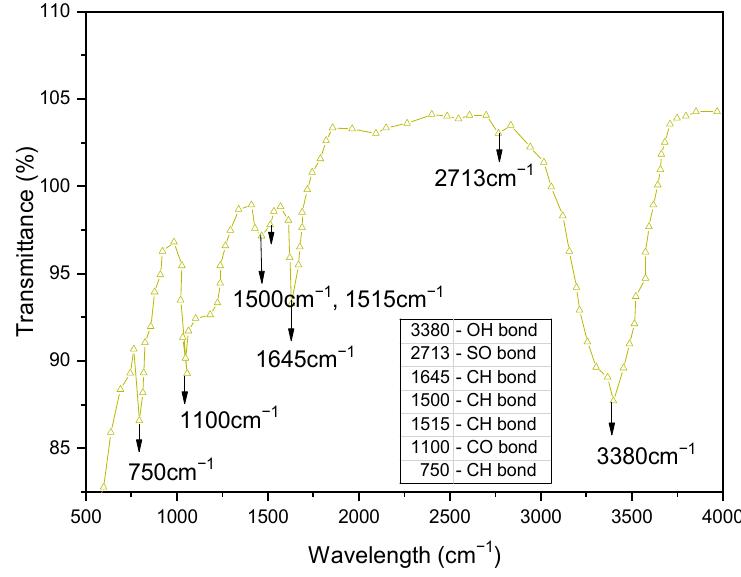
Figure 13. FTIR pattern of calcium lignosulfonate.